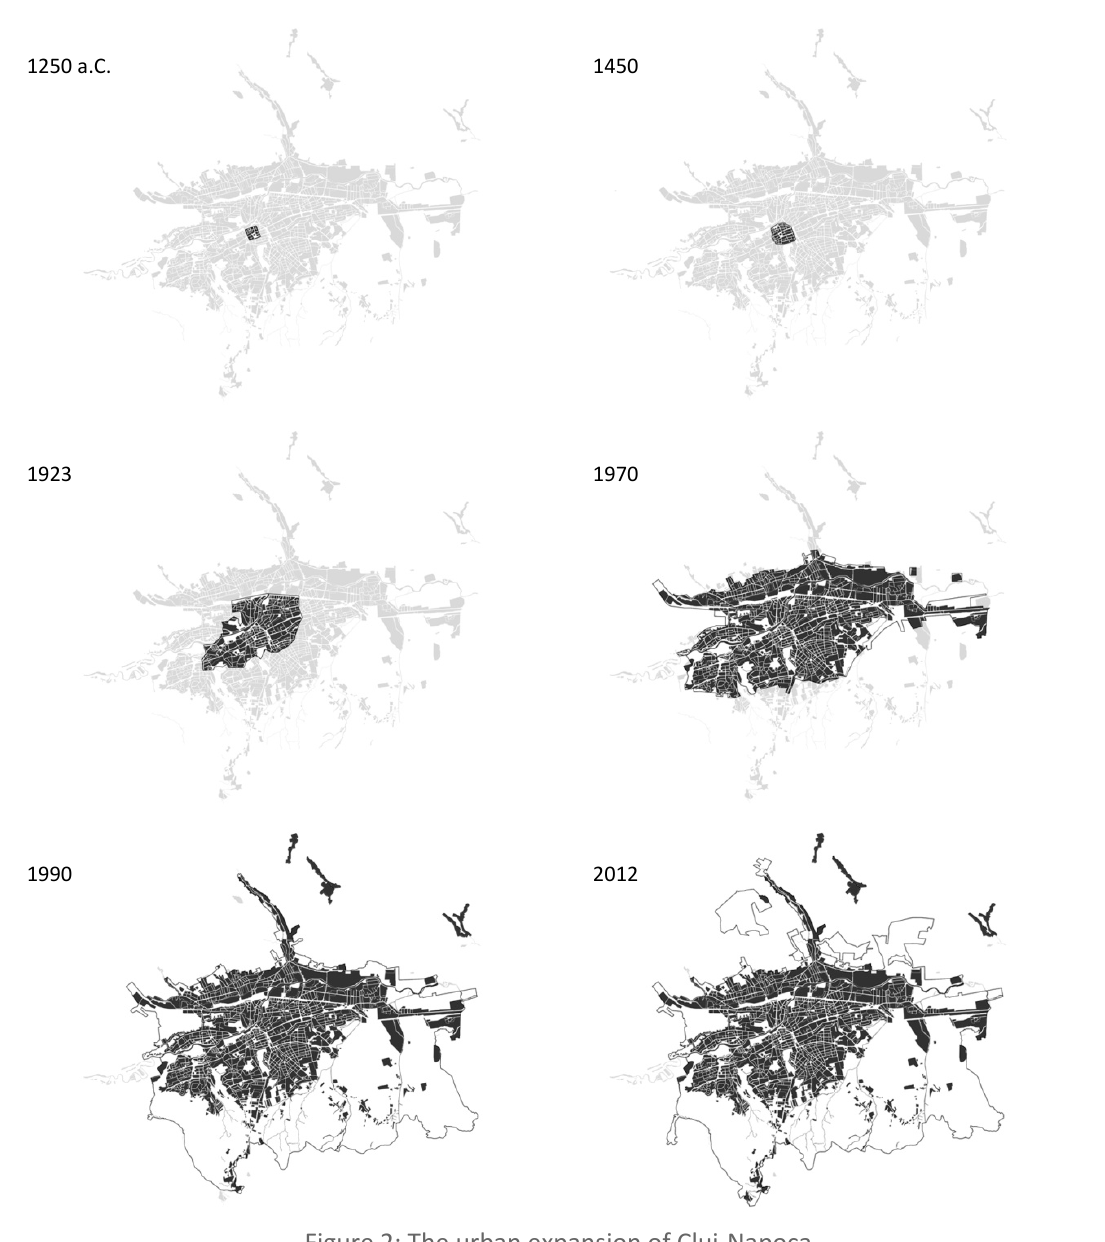
Figure 2: The urban expansion of